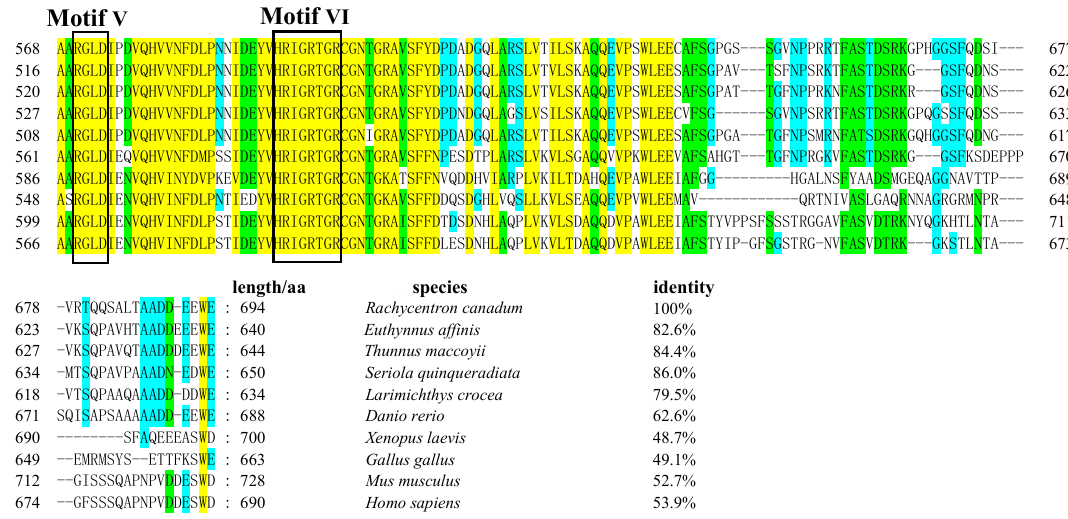
Figure 1. Multiple alignment of Rcvasa deduced amino acid sequences. The framed regions indicate the eight conserved functional motifs.